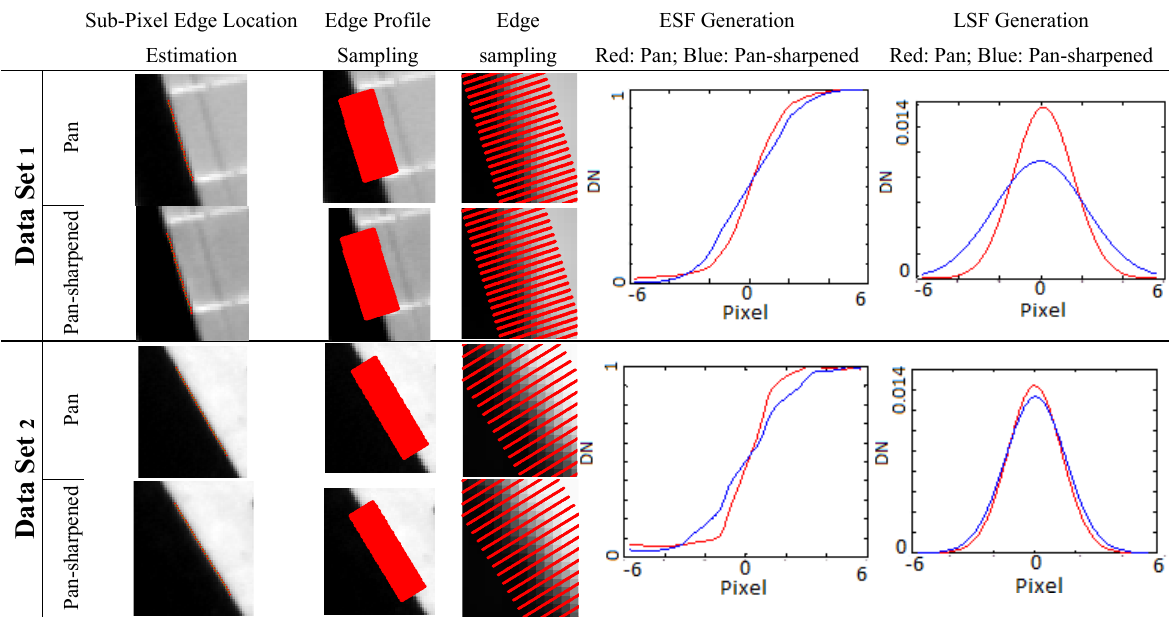
Figure 9. Samples of proposed MTF estimation strategy from sub-pixel edge locations estimation to LSF calculation in both data sets.